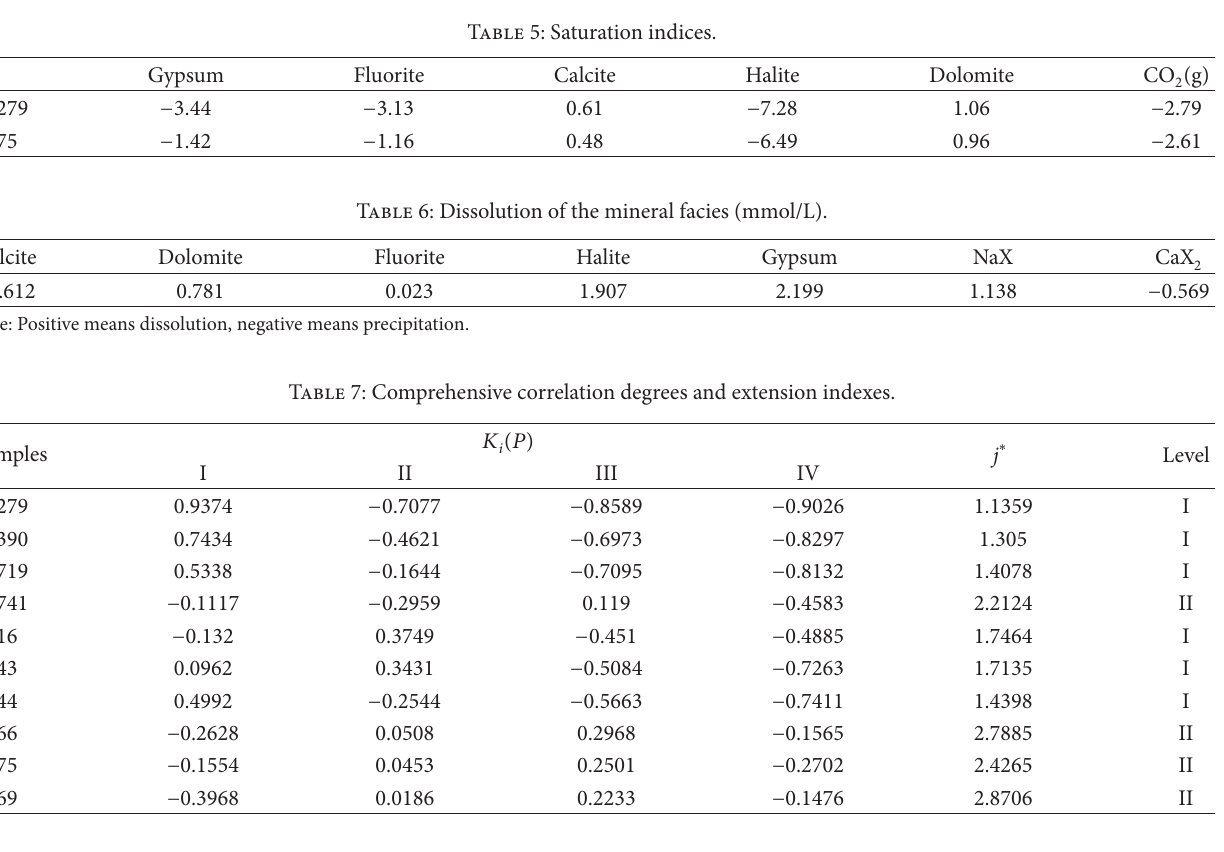
T 8: Comparison of the results of the two